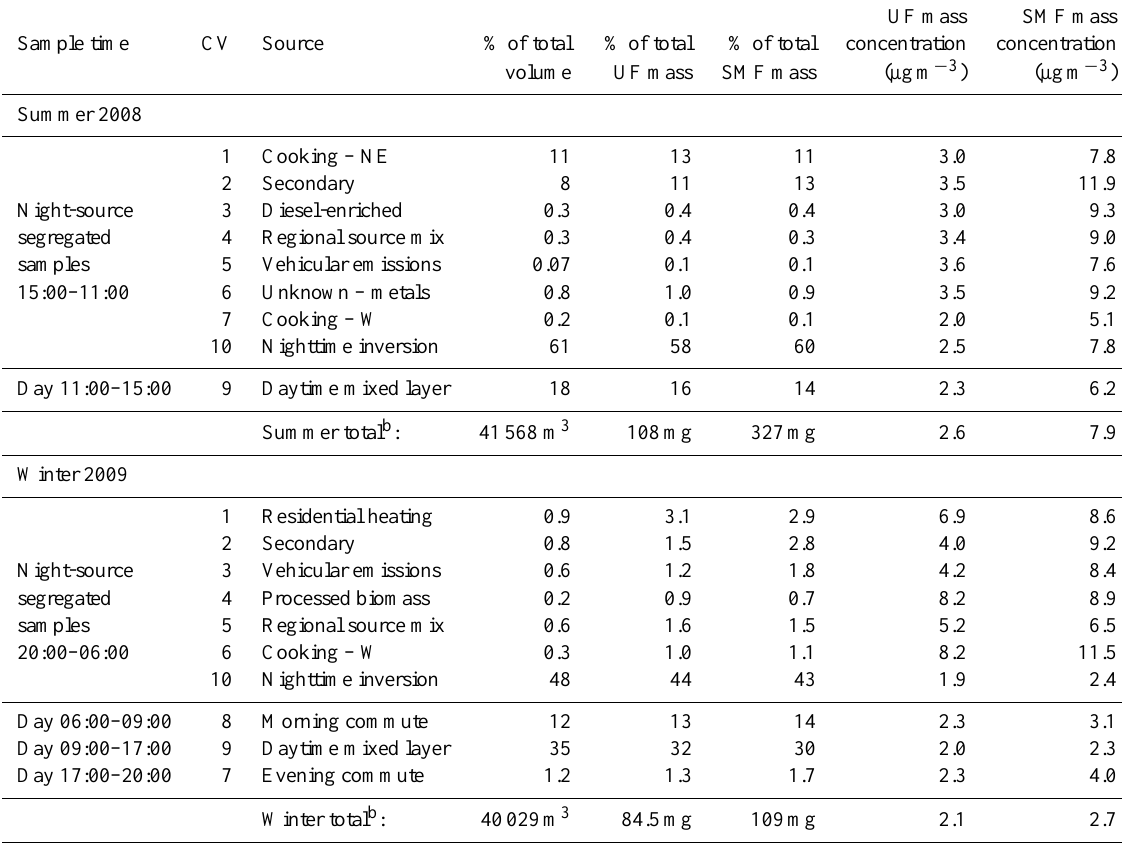
Table 1. CV sample characteristics a